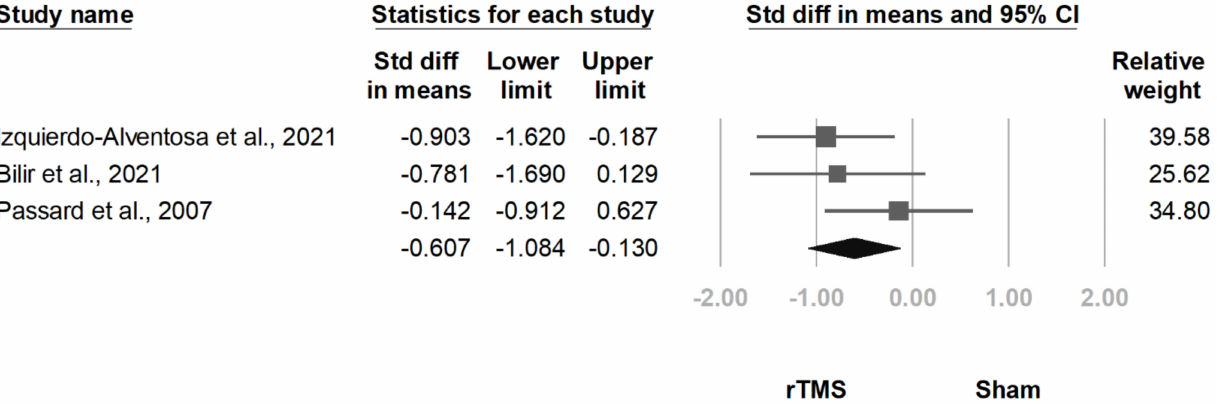
Figure 20. Forest plot of standardized mean differences in anxiety subscale of the Hospital Anxiety and Depression Scale after treatment. Squares indicate effect sizes of individual studies, lines indicate 95% CI, and diamond indicates the summarized effect size.